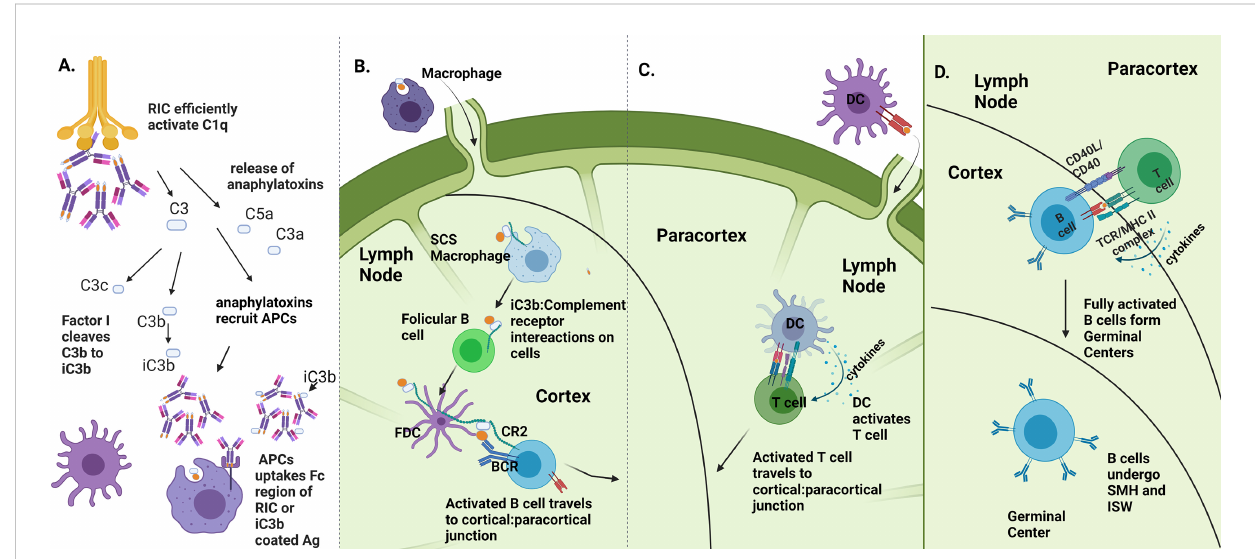
FIGURE 7 Proposed mechanisms of RIC immune enhancement. (A) RIC platform enhances complement activation. RICs activate C1q which in turn activates the complement cascade, causing release of C5a and C3a as cleavage products and downstream production of iC3b. Anaphylatoxin release recruits immune cells, including APCs to site of vaccination, which are able to uptake RIC antigen via iC3b:CR2 interactions and Fc:FcR interactions, made more potent via the RIC platform. (B) Enhanced uptake and iC3b production leads to more ef fi cient B cell activation. Presence of iC3b is required for full B cell activation via presentation of antigen from follicular dendritic cells to naïve B cells. If B cells recognize both antigen and iC3b, B cells to migrate to cortical-paracortical junction to gain T cell help. (C) Enhanced DC activation and recruitment leads to more ef fi cient T cell activation. DCs that were recruited to vaccination site travel to LN to activate T cells. Activated T cells travel to cortical: paracortical junction. (D) B cells gain T cell help and can effectively undergo af fi nity maturation. After getting help from T cells, B cells form germinal centers where they undergo somatic hypermutation and isotype switching. ( Image created using BioRender.com